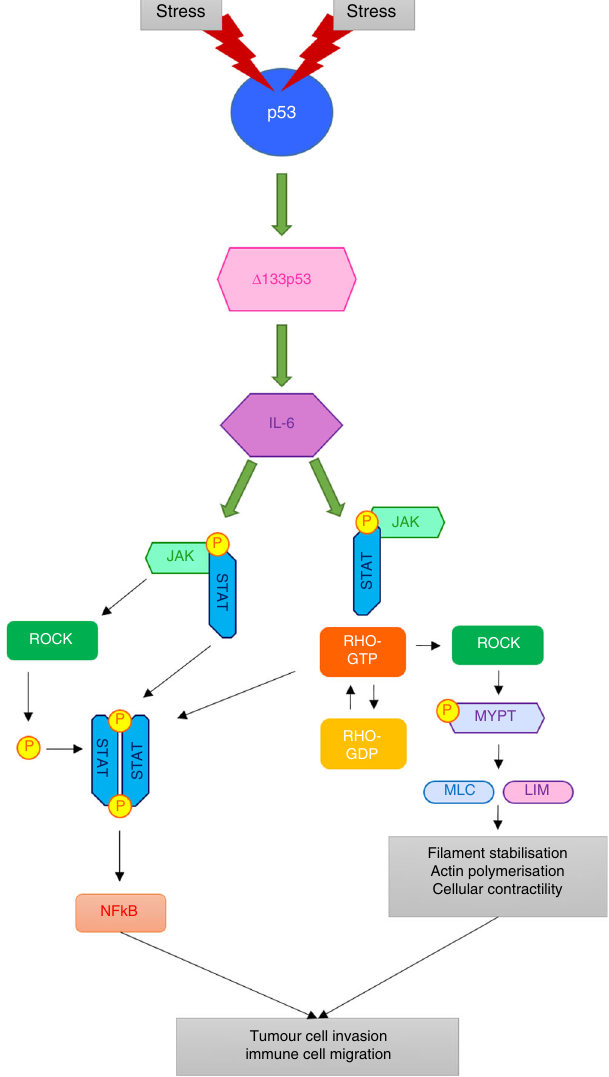
Fig. 8 Model of how the Δ 133p53 isoform regulates the JAK-STAT3 and RhoA-ROCK pathways to promote in fl ammation and invasion. Wt p53 is activated by some (as yet unde fi ned) stress signal, which turns on Δ 133p53. Δ 133p53 increases IL-6, which, then binds to its receptor and signals through the JAK-STAT pathway to amplify the IL-6 signal